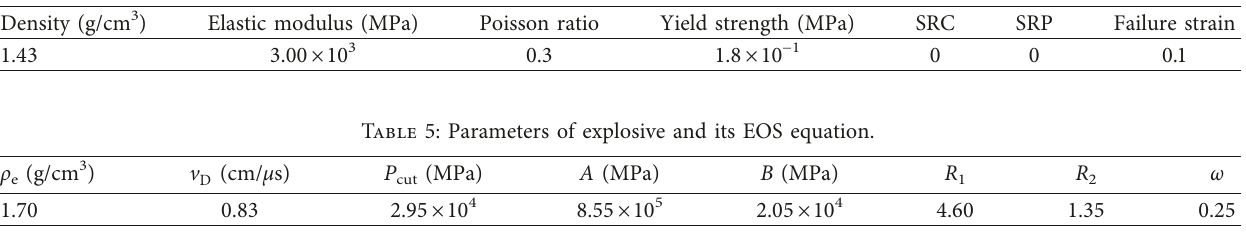
Table 4: Parameters of blasthole wall protection material.